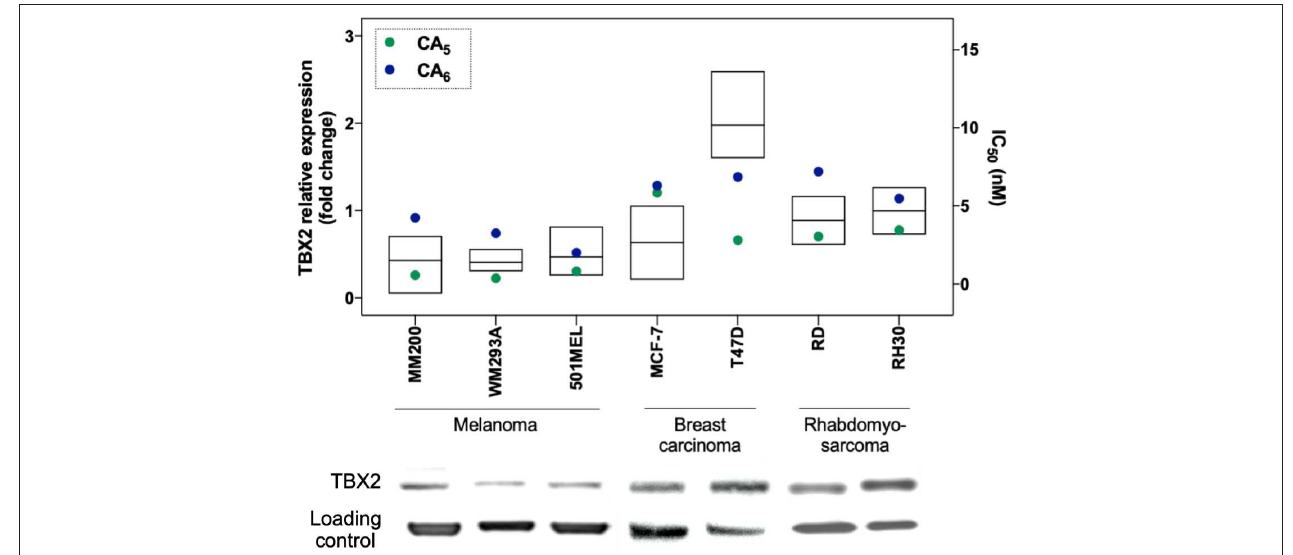
FIGURE 2 | Relative protein expression of TBX2 and cytotoxicity (IC 50 ) data in melanoma, breast cancer, and rhabdomyosarcoma cell lines. Protein expression levels are plotted in the left y axis as ratio signals for TBX2/respective loading control obtained from the densitometry readings using UN-SCAN-IT gel 6.1 software. Loading controls were obtained using α -tubulin for melanoma and breast carcinoma cells, and P-38 for sarcoma cells. IC 50 values are represented in the right y axis and were obtained by the MTT assay cytotoxicity readings after 72h exposure of drugs to the respective cell line and analyzed by non-linear regression using GraphPad Prism version 8.0 (GraphPad Software, USA) from three independent experiments performed in duplicate.